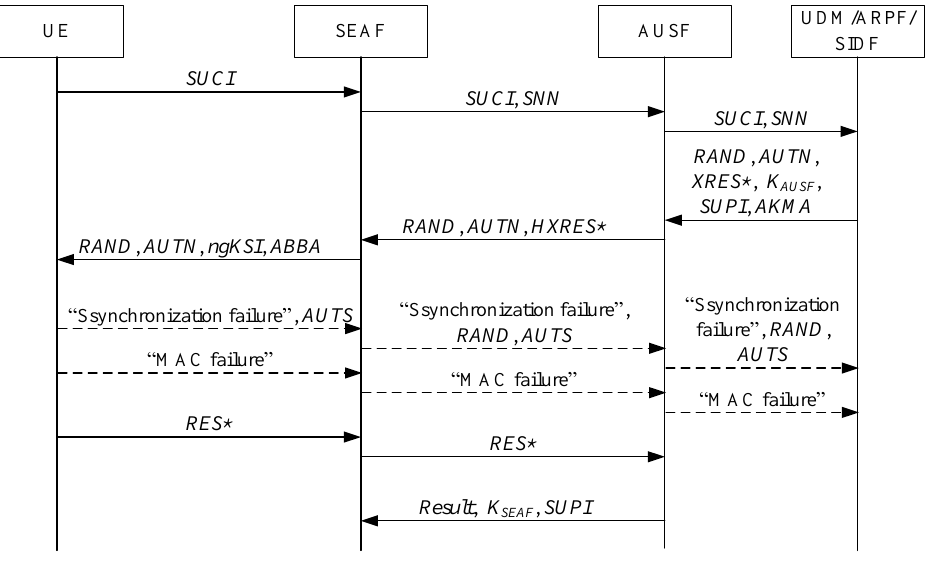
Figure 1. The steps of the latest version of the 5G AKA protocol.